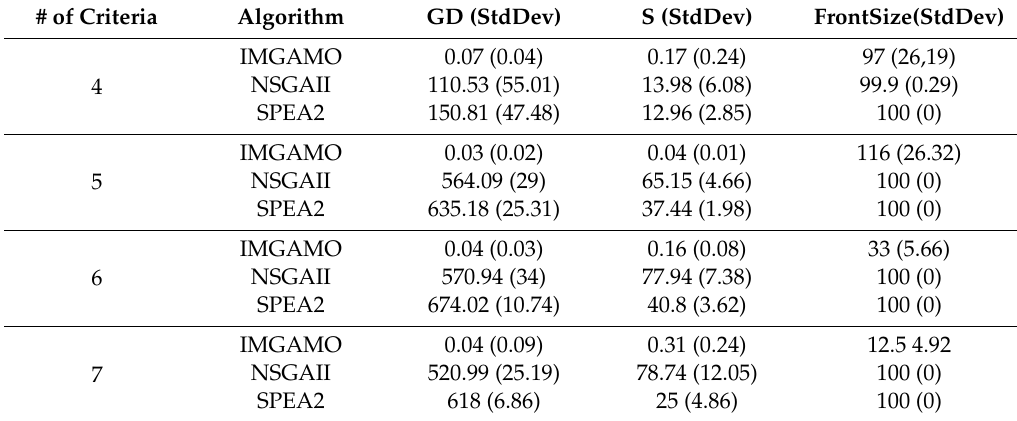
Table A3. Comparison of results for DTLZ1 problem.